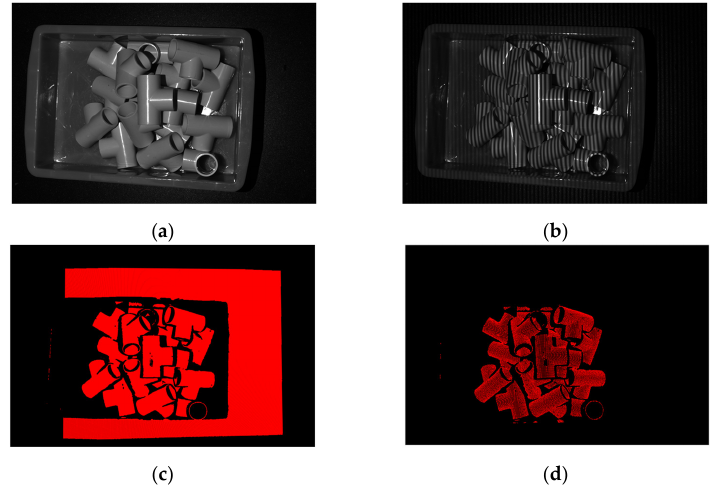
Figure 4. The results of preprocessing. ( a ) The original figure without the color of the objects, ( b ) the picture of the objects when structured light was projected, ( c ) the original point cloud we obtained; ( d ) the point cloud after preprocessing.